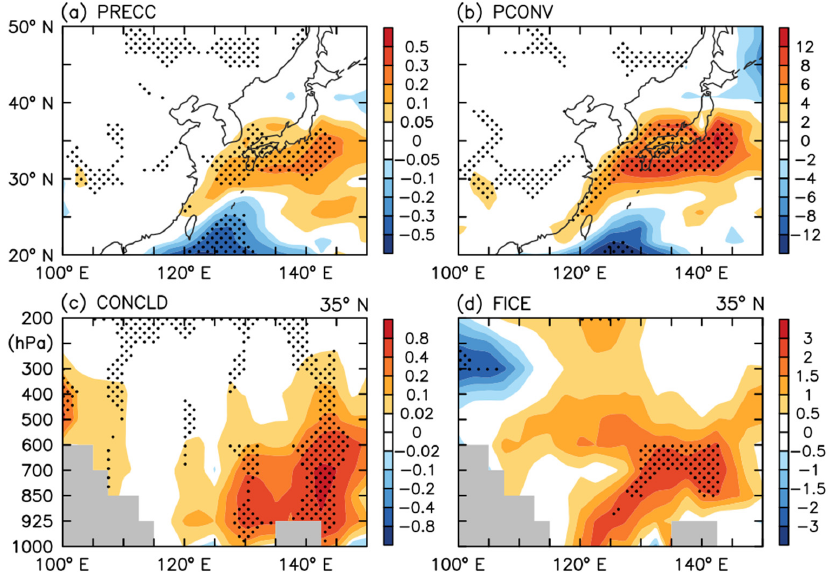
confidence level based on the MC